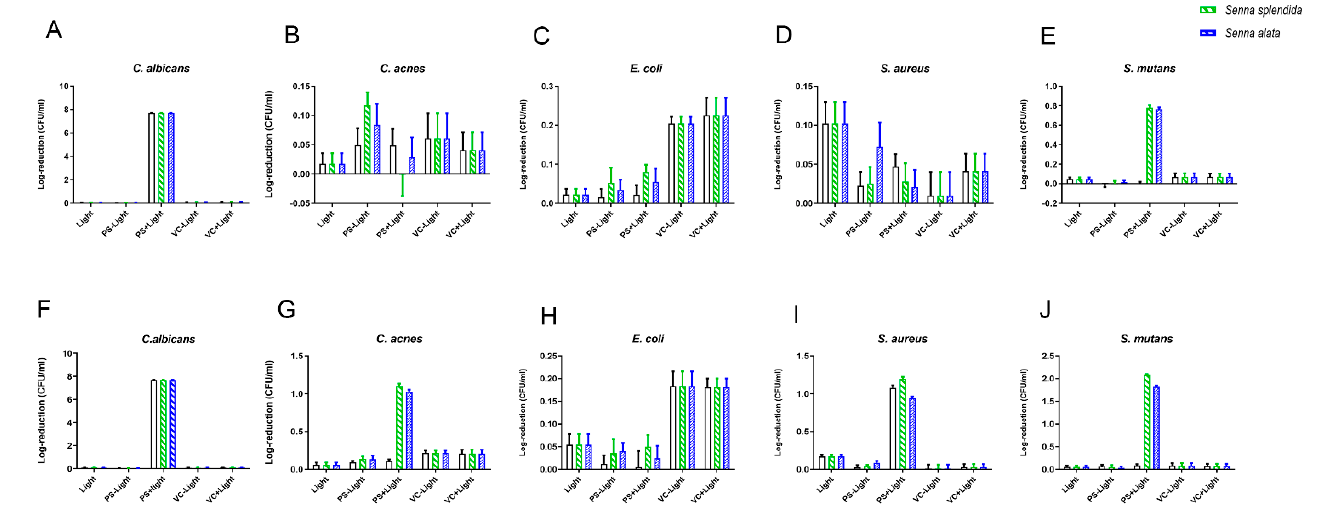
Figure 3. Effect of PDT of plant extracts (( A – E ) = 0.05 mg/mL and ( F – J ) = 0.5 mg/mL) on microorganisms in biofilms (mean ± 95% confidence interval). ( A , F ) = Candida albicans. ( B , G ) = Cutibacterium acnes. ( C , H ) = Escherichia coli. ( D , I ) = Staphylococcus aureus. ( E , J ) = Streptococcus mutans. PS − light = plant material not exposed to light; PS + light = plant material exposed to light; VC light = vehicle control not exposed to light; VC + light = vehicle control exposed to light.